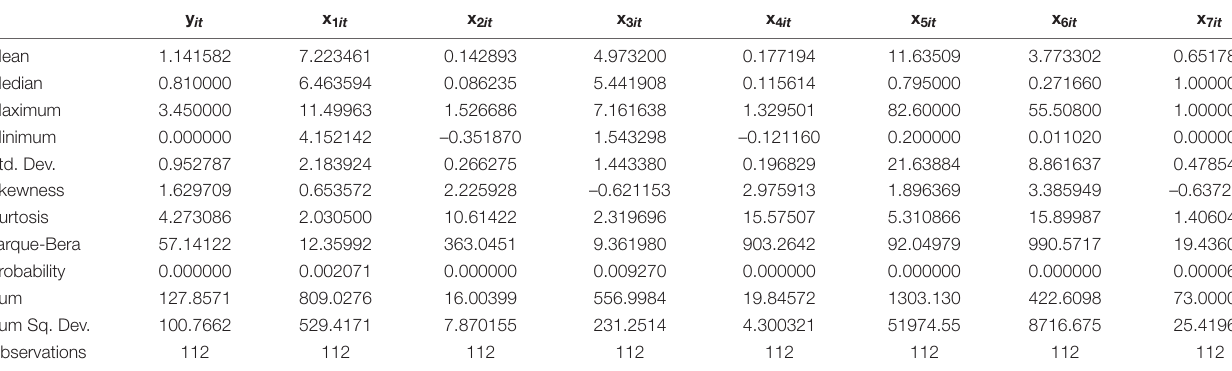
FIGURE 1 | Research framework. TABLE 2 | Descriptive statistical results of data.